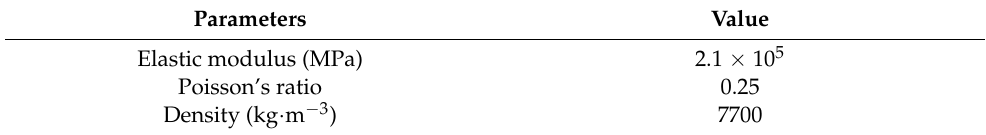
Table 2. Material properties of the reed.